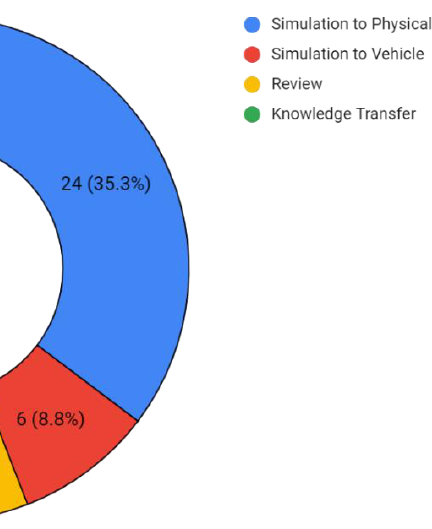
Figure 6. Distribution of selected papers according to application.